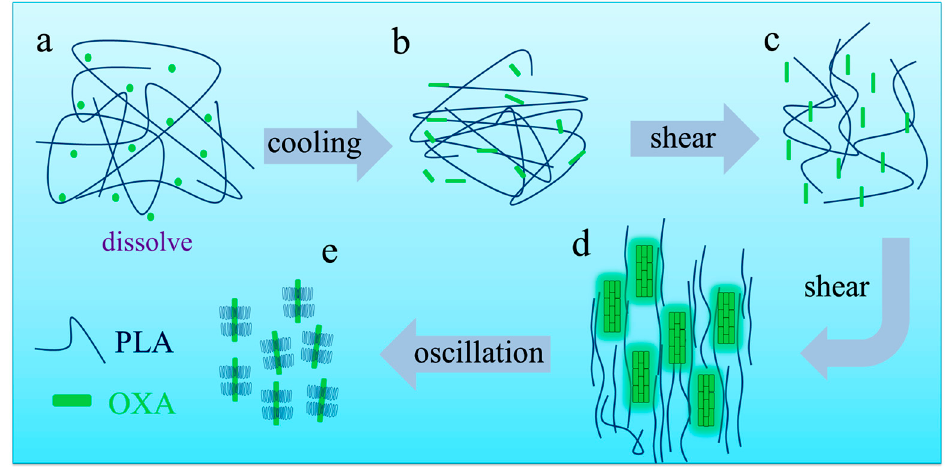
Figure 9. Schematic illustration of the enhanced crystallization kinetics of the PLLA/OXA-240 systems showing the evolution of the OXA superstructures and the orientation of the PLLA macromolecules in the presence of shear flow. ( a ) PLLA/OXA melt with dissolved OXA molecules; ( b ) self-organization of OXA in the PLLA melt; ( c , d ) the OXA fibrils and PLLA molecules gradually orientate in the shear direction; ( e ) crystallization of PLLA.